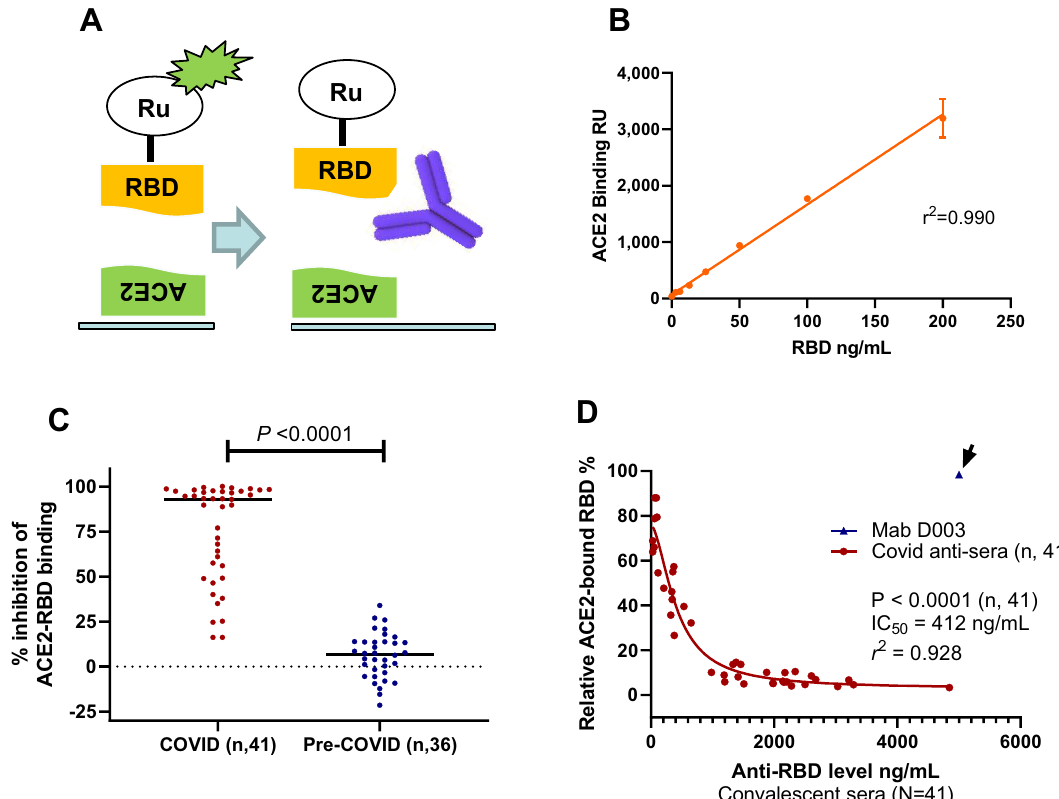
Figure 2. Neutralization assay, sensitivity, specificity, stability, and association with RBD antibody levels in COVID-19 convalescent sera. ( A ) Diagram of RBD and ACE2 biding assay and serum neutralization assay, where the neutralizing antibody prevents RBD from binding to ACE2. ( B ) Linearity of the RBD-ACE2 binding assay where increased RBD results in linear increase of binding signal ( r 2 = 0.990). ( C ) Neutralization data showing the convalescent sera have much higher neutralizing ability ( P < 0.0001). ( D ) Serum neutralization assay results using COVID-19 convalescent sera showing strong correlation between anti-RBD levels and neutralizing activity ( P < 0.0001, N = 41). The inhibitory concentration (IC 50 ) shown was determined using nonlinear regression inhibitory model using RBD antibody levels in the sera, without accounting for a sixfold sample